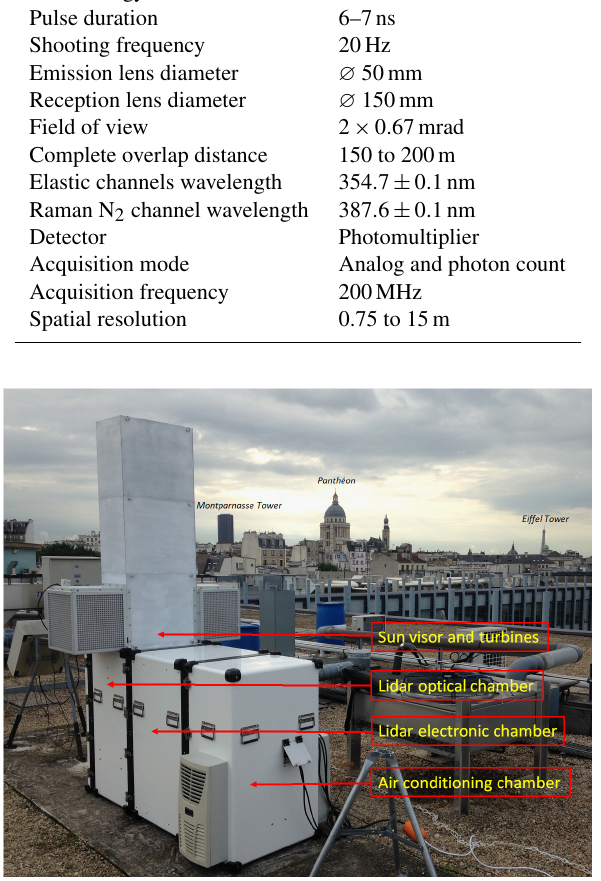
Figure 1. LAASURS system on the Paris Sorbonne University